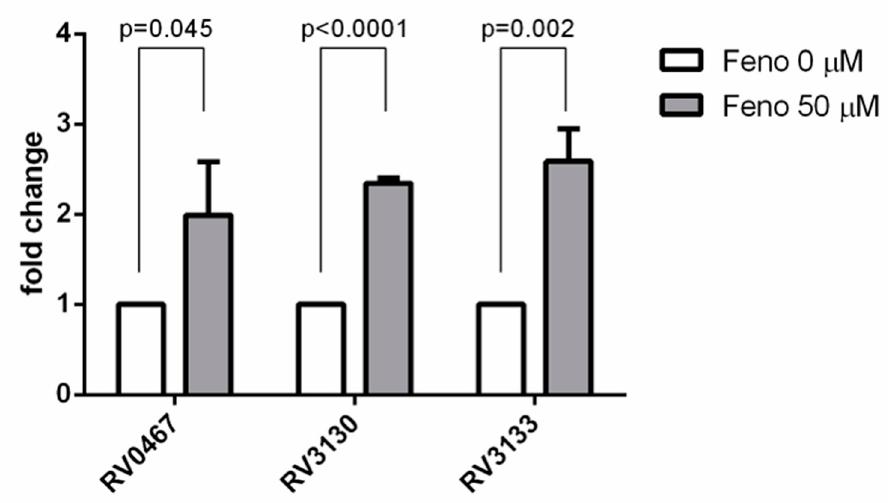
Figure 4. The effect of fenofibrate treatment on the transcriptional response of Mycobacterium tuberculosis (Mtb) contained within human macrophages. The mRNA expression levels of Rv0467, Rv3130, and Rv3133 were analyzed on day 2. Data are shown as means ± SEMs, and statistical difference was analyzed using an unpaired t- test.